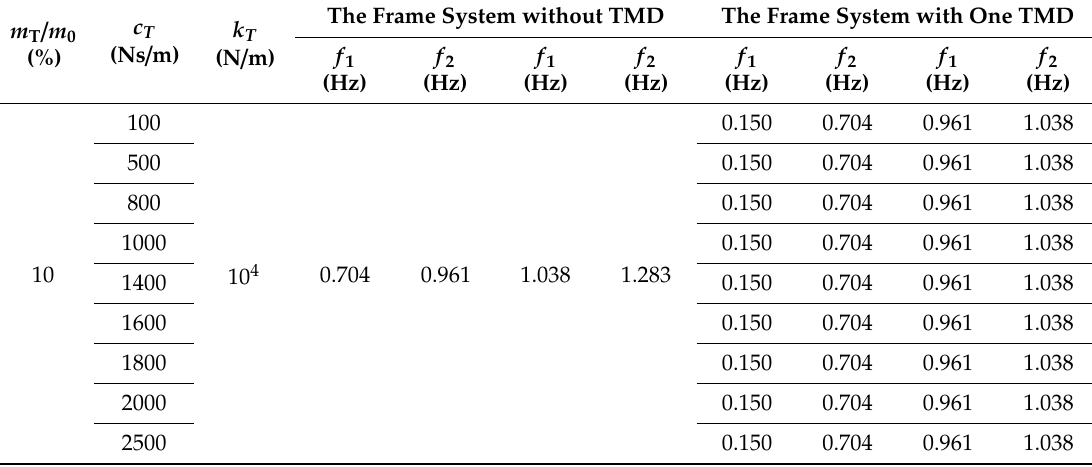
Table 10. Variation of the first natural frequencies of the space frame system as a function of c T . m T / m